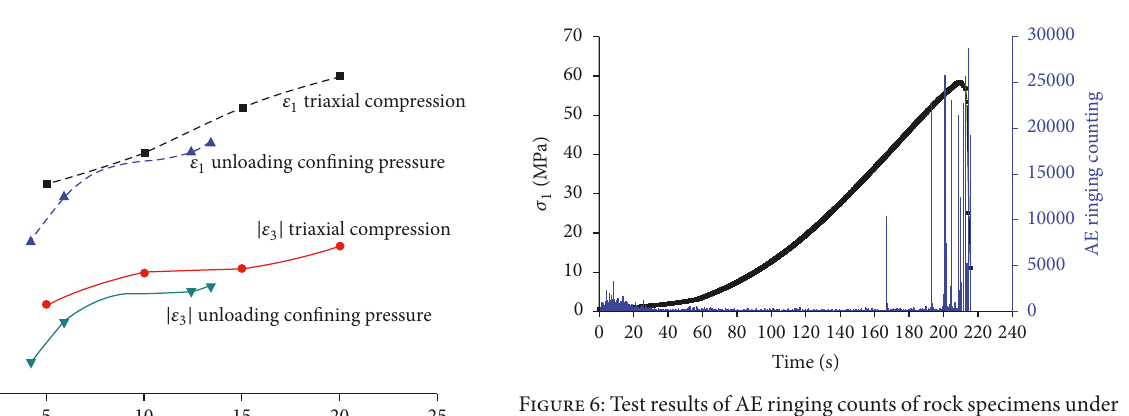
Figure 6: Test results of AE ringing counts of rock specimens under unaxial